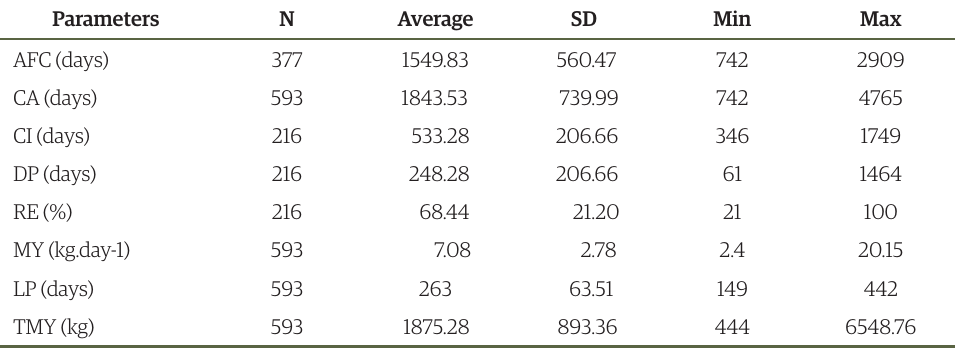
Table 1. General average of age at first calving (AFC), calving age (CA), calving interval (CI), dry period (DP), reproductive efficiency (RE), milk yield (MY), lactation period (LP) and total milk yield (TMY) of Red Sindhi cows and their respective standard deviations (SD), minimum and maximum (max)